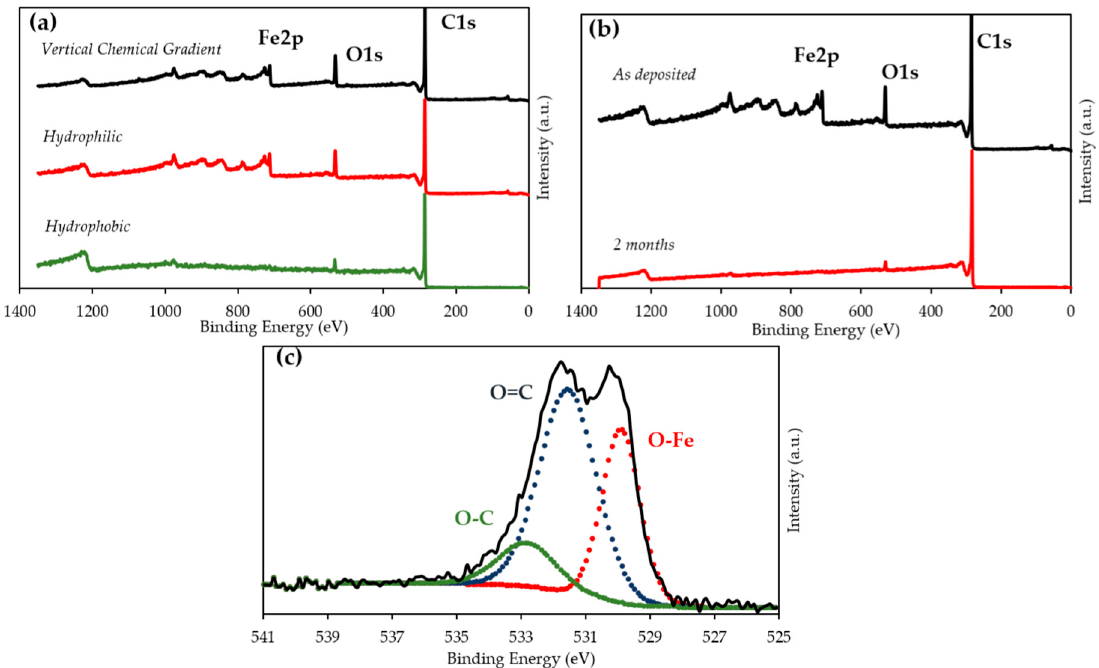
Figure 4. ( a ) XPS surveys for the Photo-initiated chemical vapor deposition PICVD-treated samples as deposited; ( b ) hydrophilic XPS survey as deposited and after 2 months; ( c ) high resolution O1s of the hydrophilic samples.